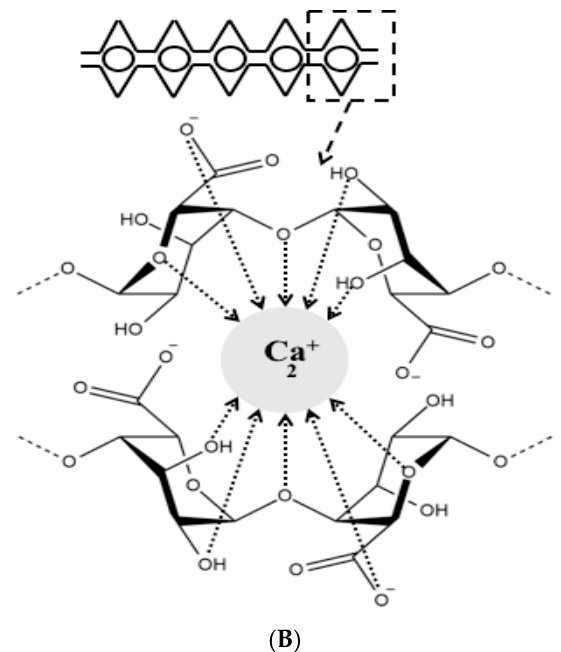
Figure 1. Chemical structure of alginate displaying the d-mannuronate (M) and l-guluronic (G) blocks ( A ), schematic representation of calcium binding to alginate to form an egg-box shape ( B ).